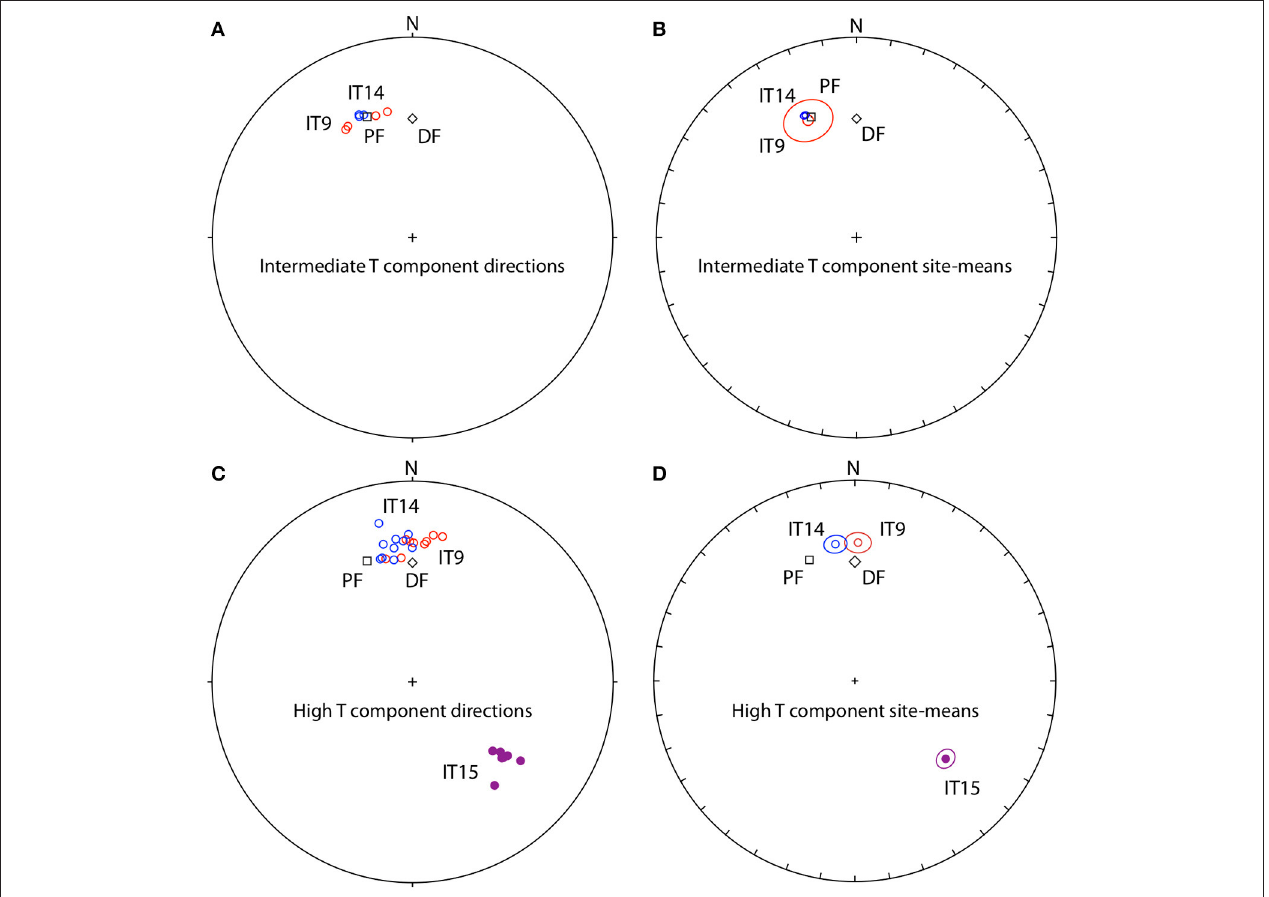
FIGURE 3 | Directions isolated from the mafic sills: (A) intermediate temperature component directions isolated from sills at IT9 (red) and IT14 (blue), the present-day field direction (PF) and the time-averaged dipole field (DF) are the black square and diamond, respectively, open (closed) symbols are for upper (lower) hemisphere projections, respectively; (B) site-mean directions for the intermediate temperature-component magnetizations, symbols as in (A) ; (C) high-temperature component directions isolated from the mafic sills, symbols as in (A) , site IT15 (purple); (D) site-mean directions for the high temperature-component magnetizations, symbols as in (A)